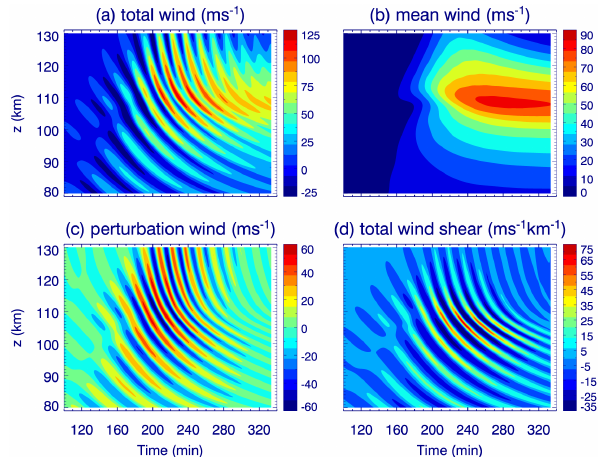
Figure 7. Same as Fig. 2, but for the case ES (GW with λ z = 10km).